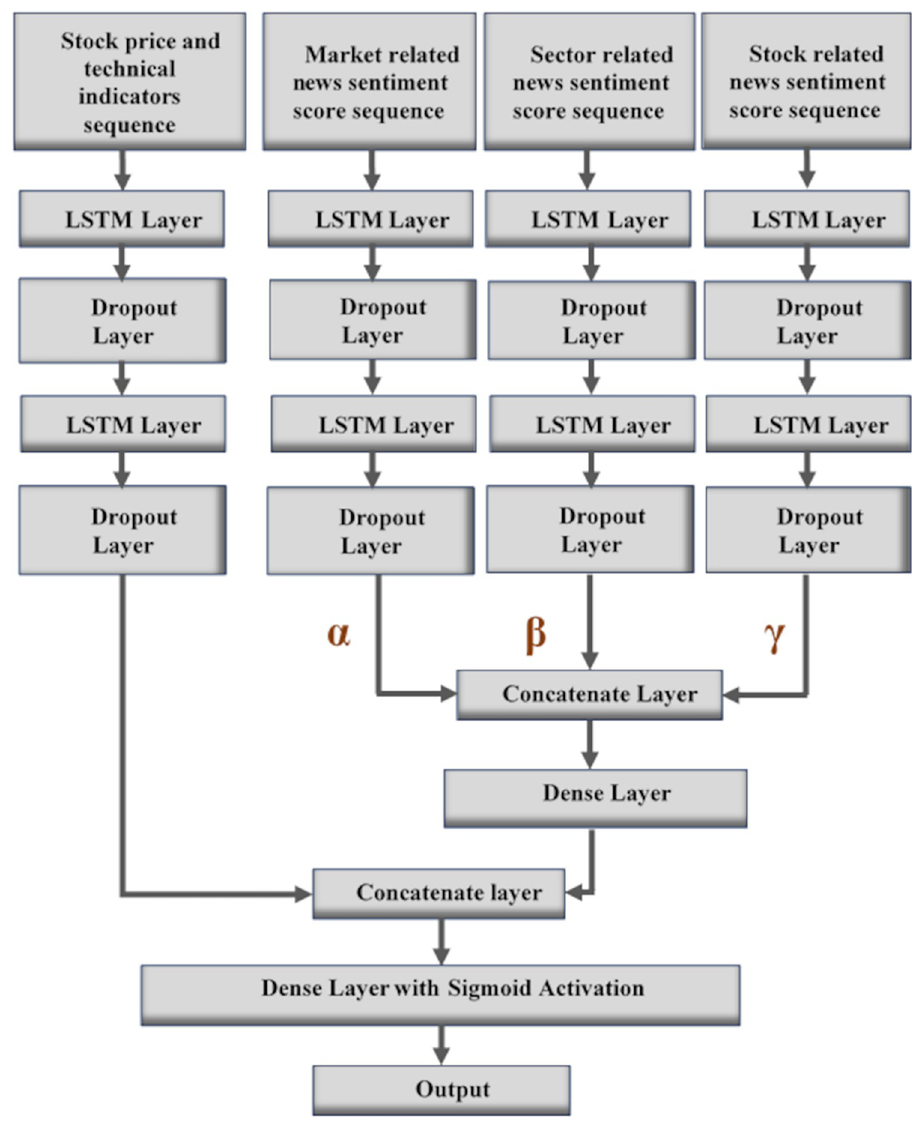
Fig 2. Architecture of the LSTM based Weighted Categorized News (WCN-LSTM) prediction